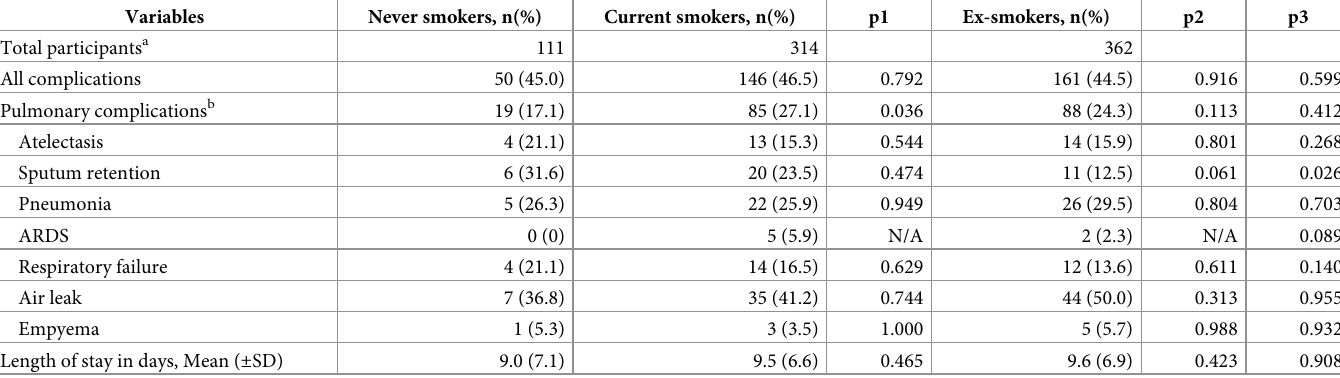
Table 2. Complication rates grouped by smoking status.